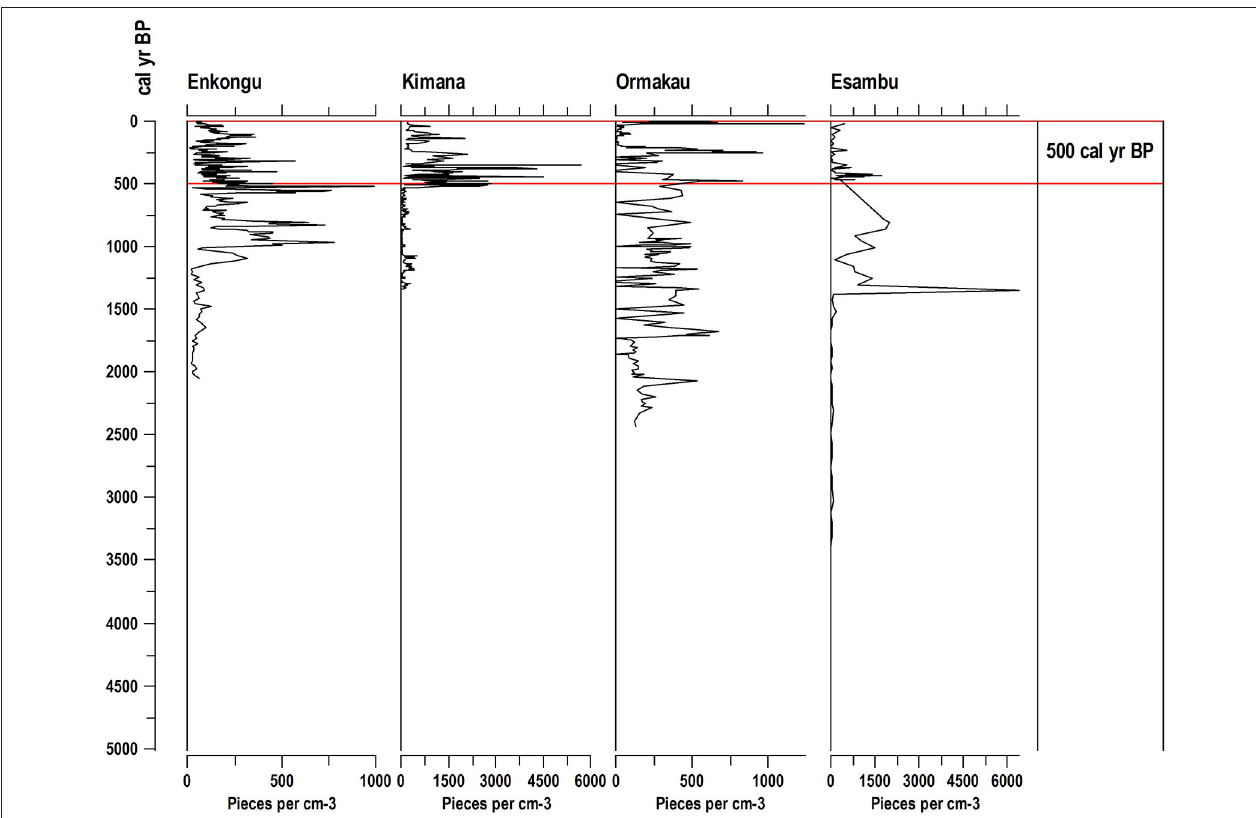
FIGURE 4 | Macrocharcoal records from the Esambu, Kimana, Ormakau and Enkongu sediment records since the mid Holocene. The ∼ 500 cal yr. BP zone where macrocharcoal concentration changes differ significantly across the sites is highlighted.